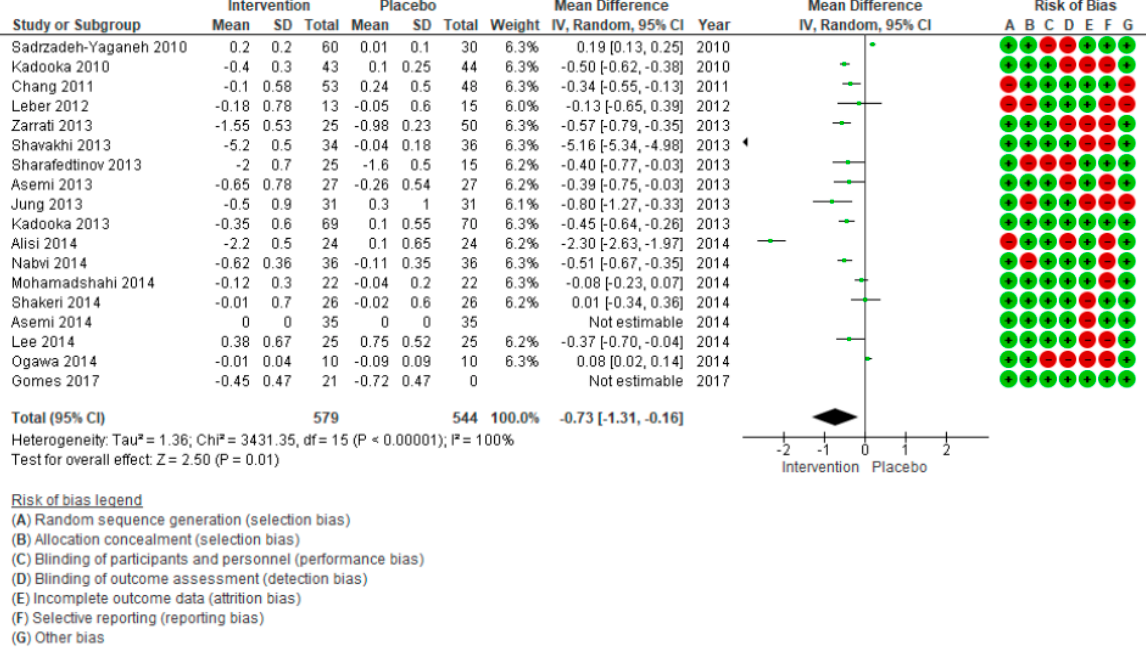
Figure 2. Forest plot for randomized controlled trials of probiotic supplementation included in body mass index (kg/m 2 ) subgroup meta-analysis ( n = 1123). The studies are listed by first author and year. IV = equation that can be estimated by inverse variance (linear, exponential). The square represents the measures of effect (i.e., an odd ratios) for each study; the area of each square is proportional to the study’s weight in the meta-analysis. Horizontal line represents the confidence interval (CI) at the 95% level. The diamond represents the meta-analyzed measure of effect; the lateral points of diamond indicate CIs for this estimate. The vertical line represents no effects; if the CI for an individual study overlaps with this line, the given level of confidence for the effect size does not differ from no effect for that study. Risk of bias indicates the level of high and low risk associated with the article, with green signal for low risk and red for high risk of bias.